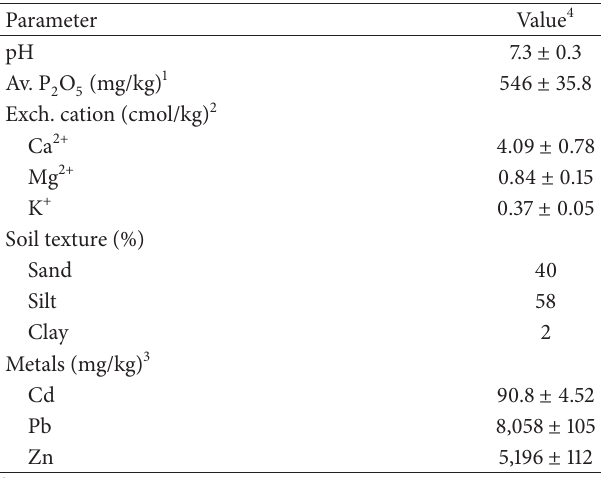
Table 3: Physicochemical properties and total heavy metal content of the soil used in this study.